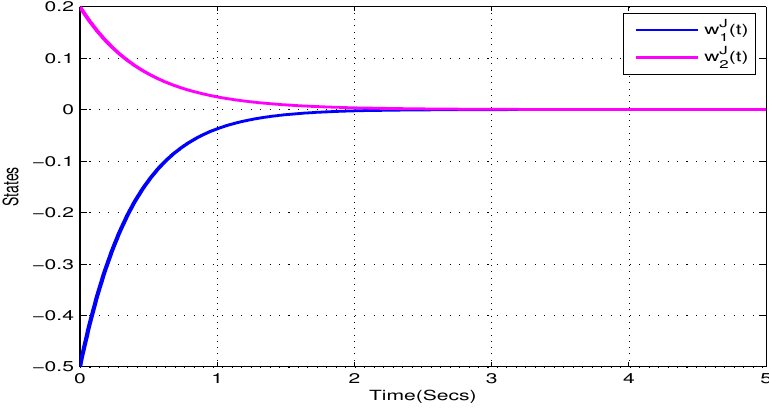
( t ) , w K ( t ) of systems (22) in Example 2 1